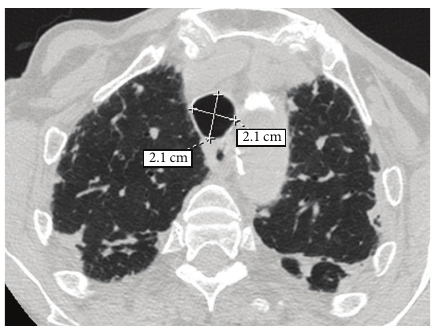
Figure 3: High-resolution computed tomography (HRCT) of the chest at the level of the upper lobes. An enlargement of the trachea at the thoracic inlet is observed measuring in both sagittal and axial dimensions 2.1 cm. A subpleural reticular pattern associated with focal thickening of the pleura and of the major fissures